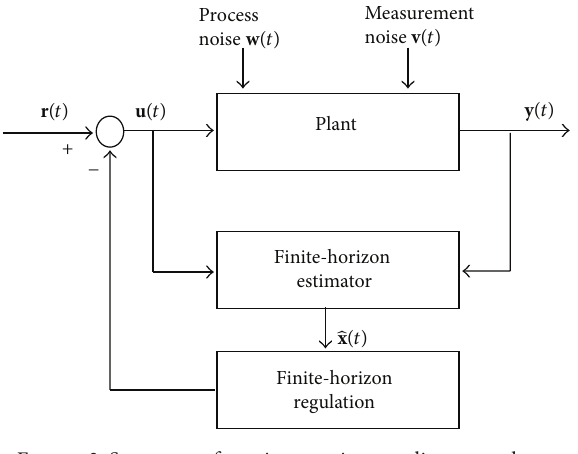
Figure 3: Summary of continuous-time nonlinear regulator.